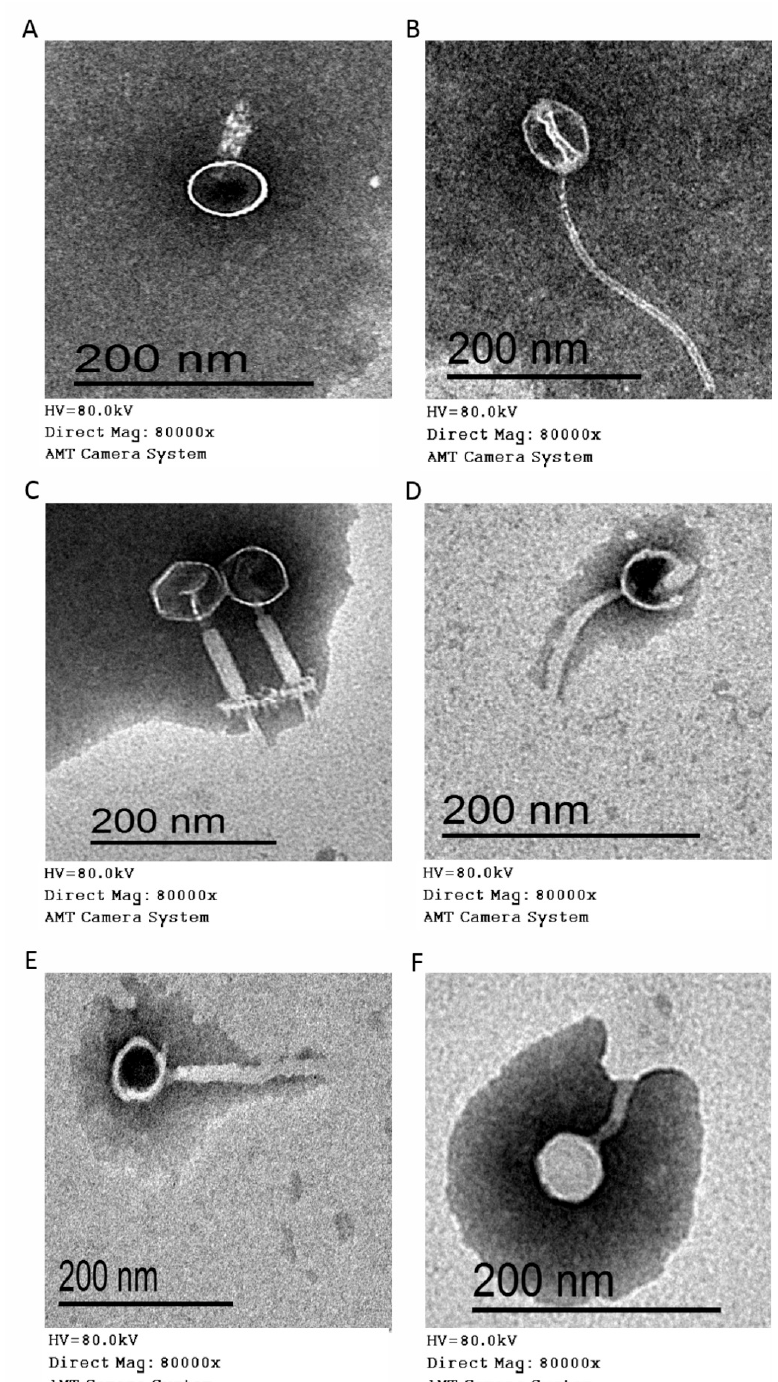
Figure 4. Electron micrographs at 80,000× of ( A ) CoNShP-1 phage, ( B ) CoNShP-2 phage, ( C ) CoNShP-3 phage, ( D ) CoNSsP-1 phage, ( E ) CoNSeP-1 phage and ( F ) CoNSeP-2 phage. Bar 200 nm.